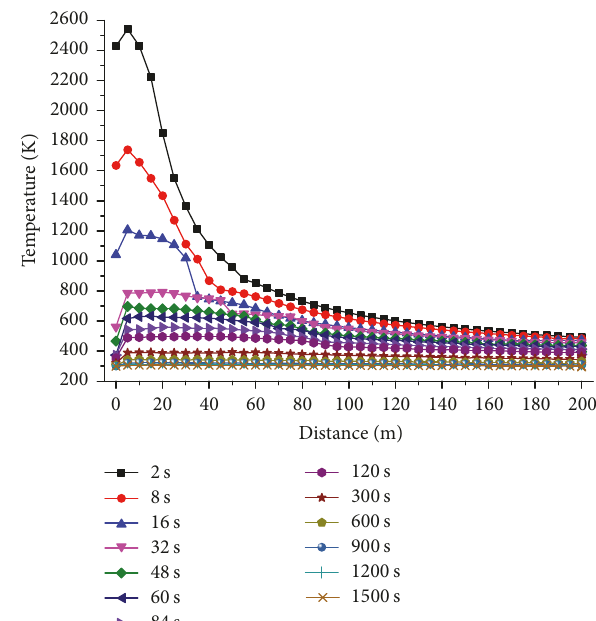
Figure 8: Spatial distribution of temperature in the blocked tunnel at different times.